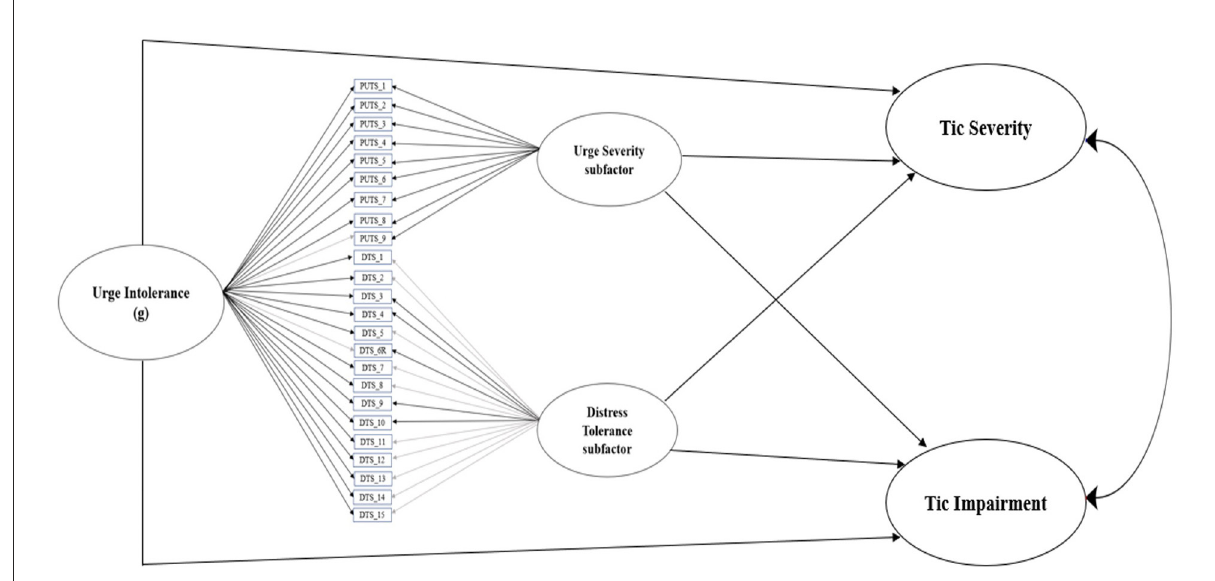
FIGURE2 Final bifactor model of urge intolerance, with urge severity and distress tolerance subfactors, predicts YGTSS tic severity and tic impairment. Black lines indicate significant standardized item loadings, while gray lines indicate non-significant standardized item loadings.